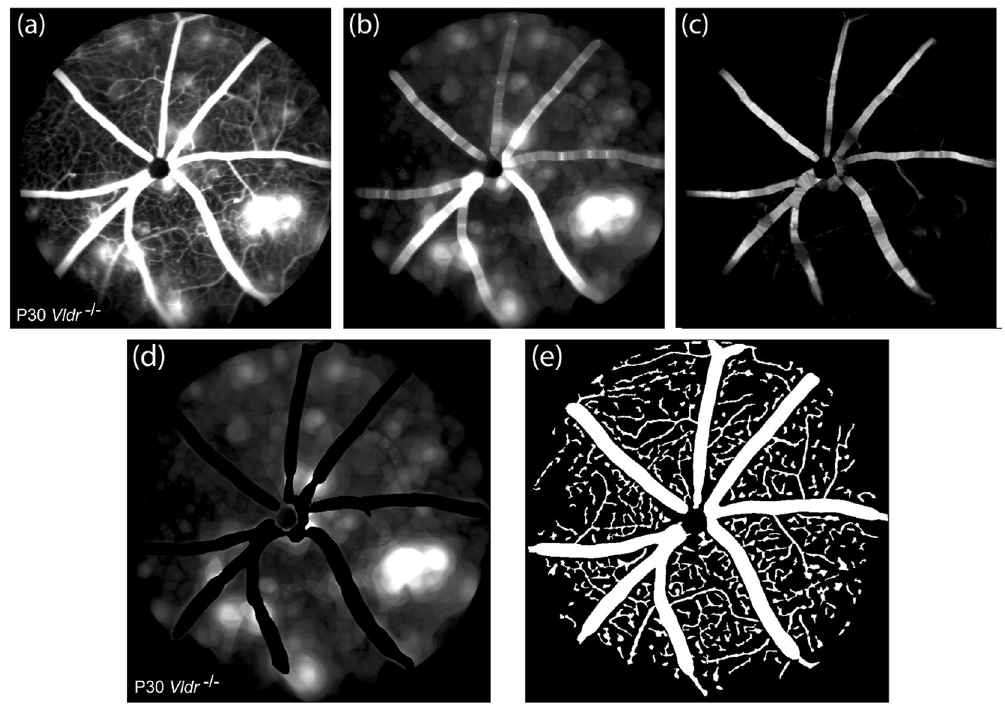
Figure 2. ( a )–( c ) Representative results of the main steps of the blood leakage quantification methodology. ( a ) ˜ I ˜ I Original image, ( b ) image v obtained after grayscale opening l obtained after small vessel removal, ( c ) image using orthogonal structuring elements. ( d , e ) Representative images obtained from our method. ( d ) Blood leakage image obtained after small and large vessel removal. ( e ) Segmented blood